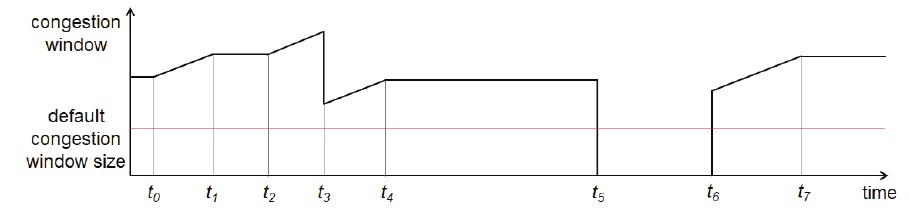
Figure 7. Change in the congestion window by event in the proposed